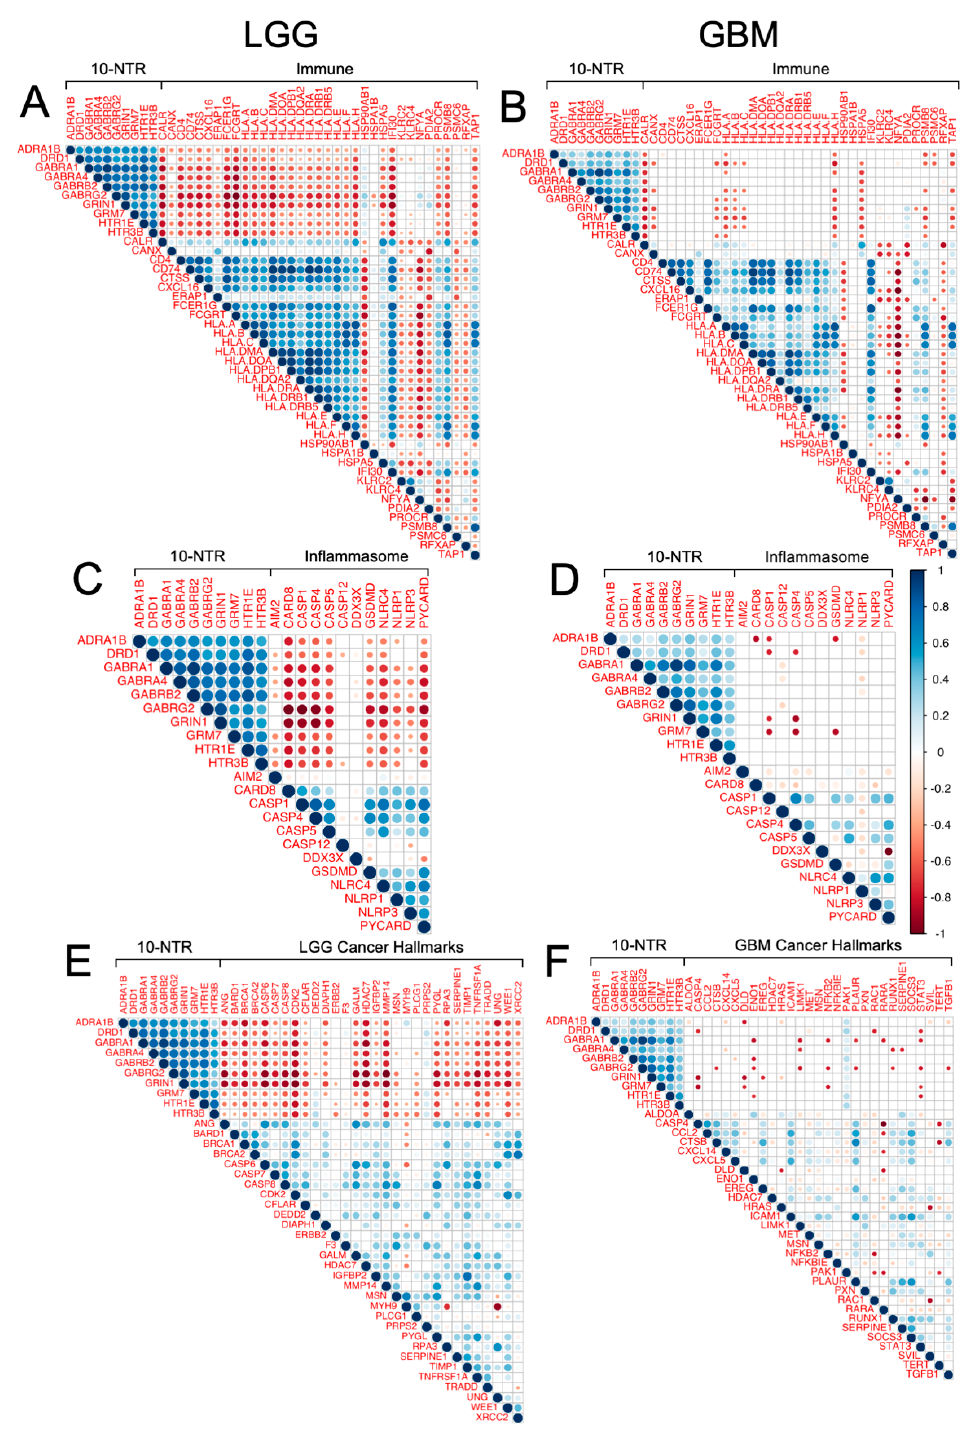
Figure 6. Correlation analysis between the 10-NTR genes and genes associated with immune response, inflammasomes, and cancer hallmarks. ( A ) Correlation between the 10-NTR genes and 36 immune-related genes (IRGs) in LGG. ( B ) Correlation between the 10-NTR genes and 36 IRGs in GBM. ( C ) Correlation between the 10-NTR genes and the inflammasomes genes. ( D ) Correlation between the 10-NTR genes and the 12 inflammasomes genes in GBM. ( E ) Correlation between the 10-NTR genes and LGG-specific hallmarks. ( F ) Correlation between the 10-NTR genes and GBM-specific hallmarks. Color intensity and size of the dots are proportional to the Pearson correlation coefficients. Blank spaces correspond to non-significant coefficients.